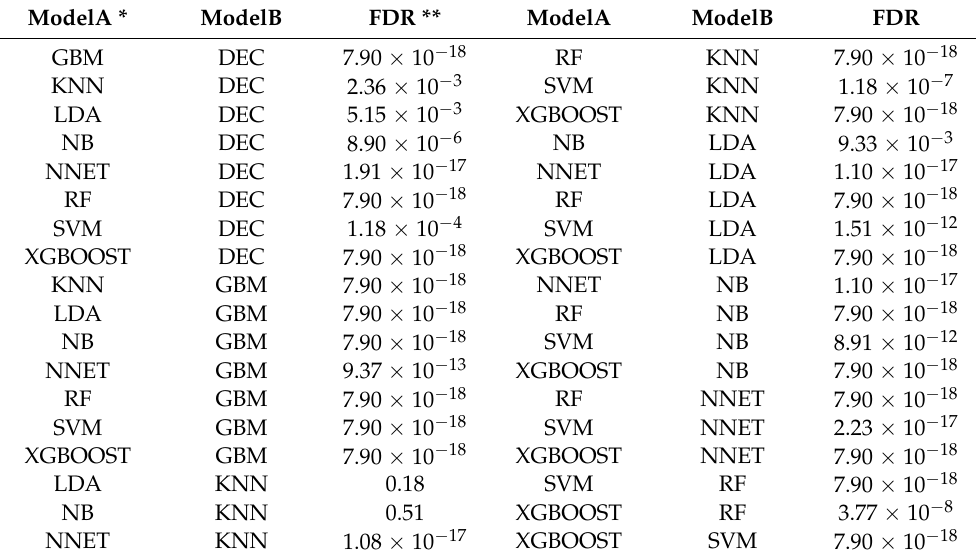
Table 4. The paired samples used in the Wilcoxon tests for the differences in the accuracies obtained from the nine machine learning